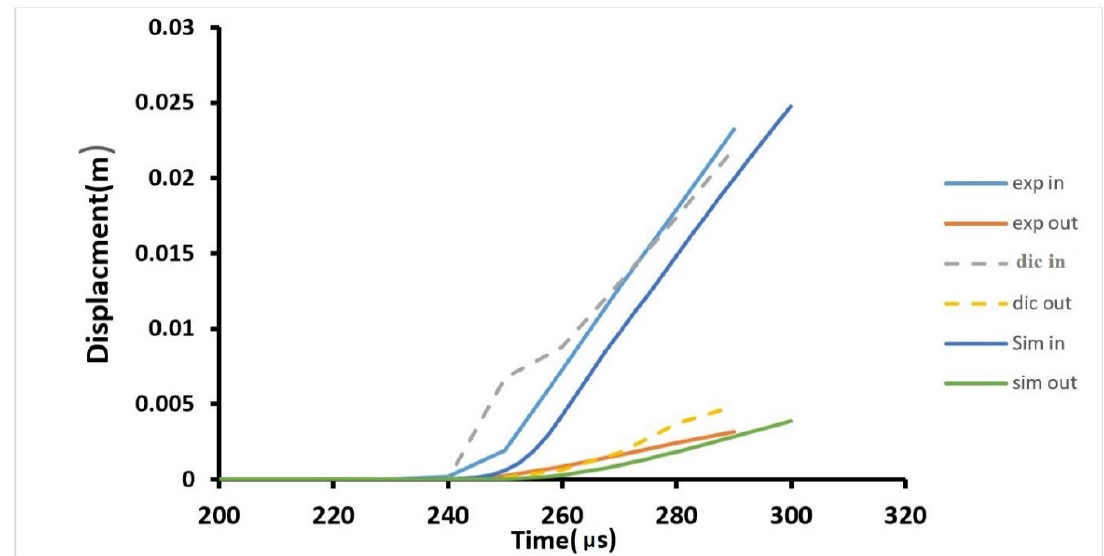
Figure 18. Displacement of two sides of the NSSS obtained by digital image correlation (DIC), simulation and SHPB.